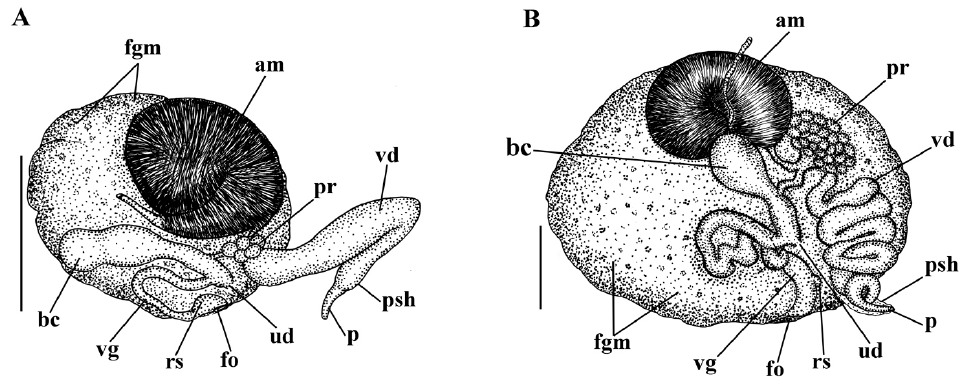
Figure 2. Reproductive systems of Dendronotus keatleyae n. sp. ( A ) and Dendronotus arcticus gartensis n. subsp. ( B ); Abbreviations: am, ampulla; bc, bursa copulatrix; fgm, female gland mass; fo, female opening; p, penis (=copulatory organ); pr, prostate; psh, penial sheath; rs, receptaculum seminis; ud, uterine duct; vd, vas deferens; vg, vaginal duct. Scale bars: 1 mm.